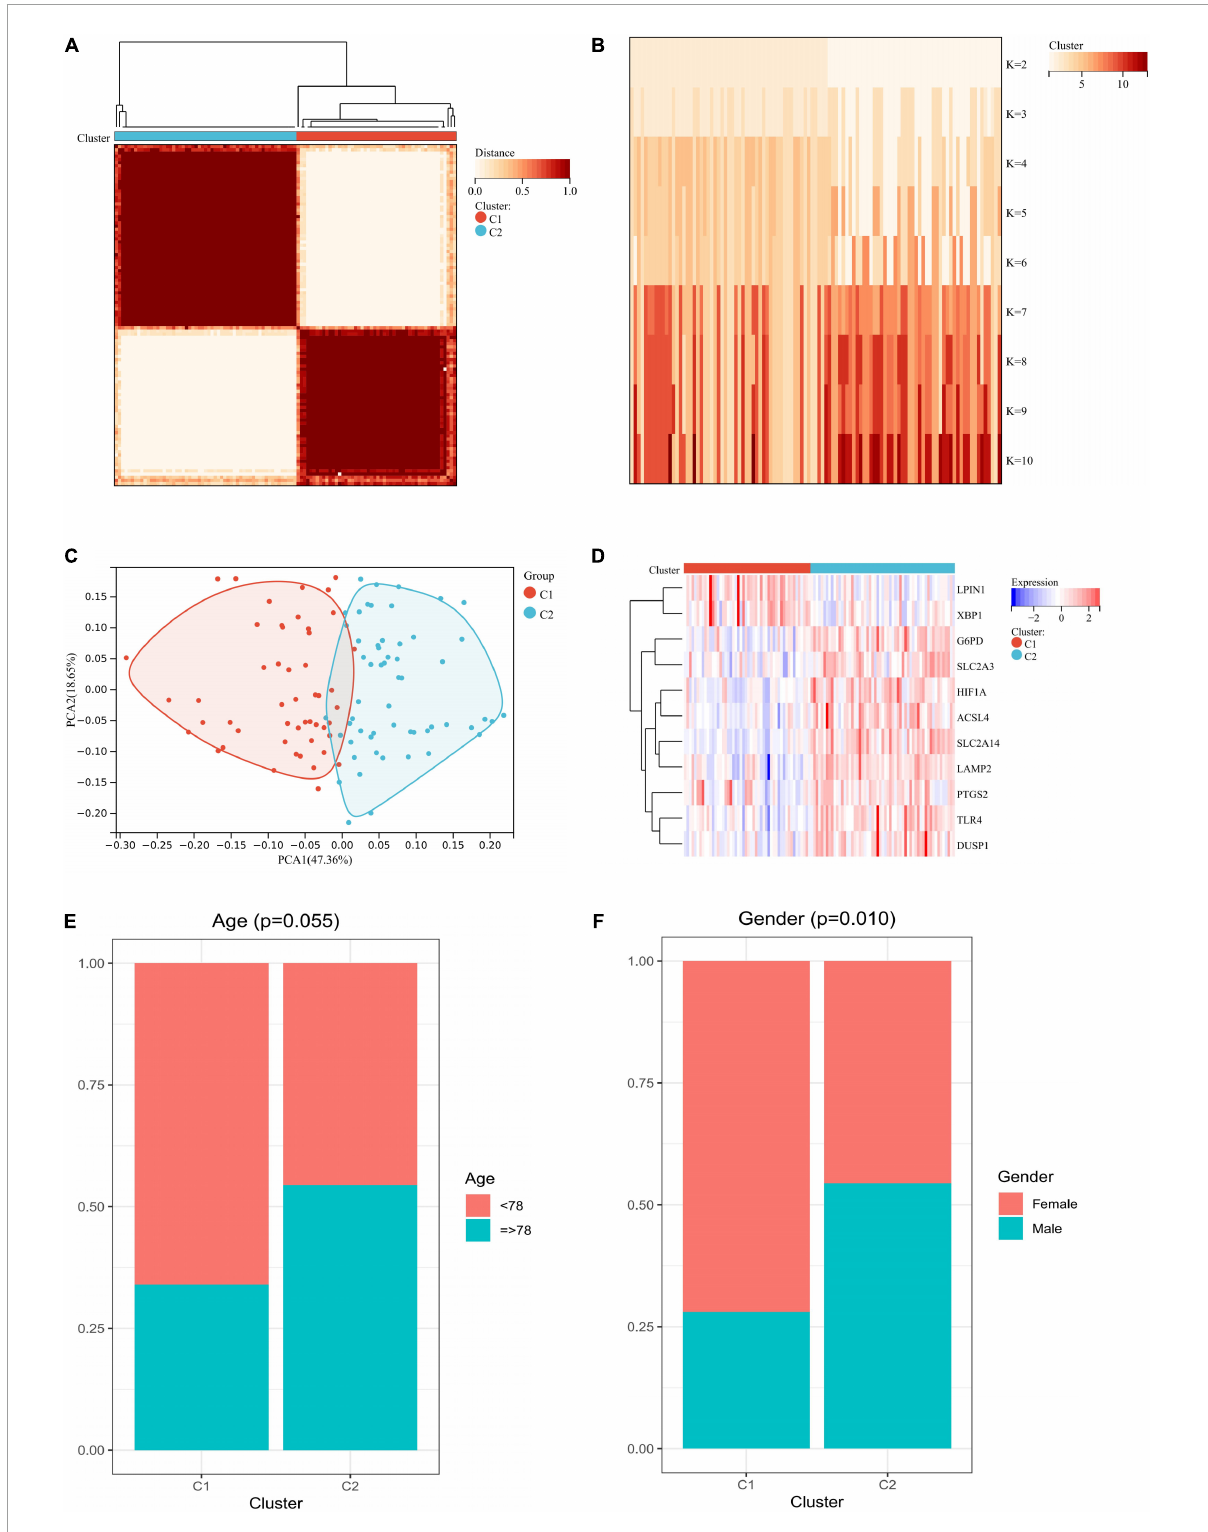
FIGURE8 Unsupervised clustering of 11 hub genes. (A) Consensus matrix heatmap when k = 2. (B) Tracking plot showing the sample classification when k = 2–10. (C) PCA plots showing a remarkable difference in transcriptome between two subtypes. (D) Heatmap showing the expression of 11 hub genes in two subtypes. (E) Age ratio distribution in the two subtypes. (F) Gender ratio distribution in the two subtypes. PCA, principal components